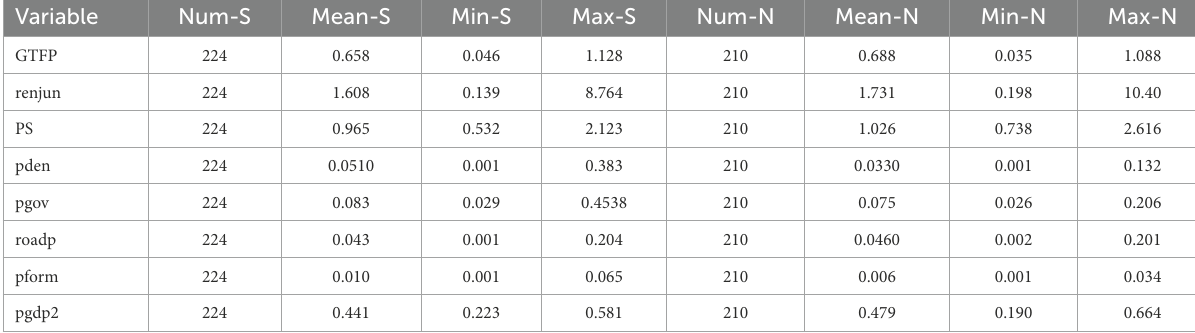
TABLE 2 Variable definition description and statistical description in south and north region.